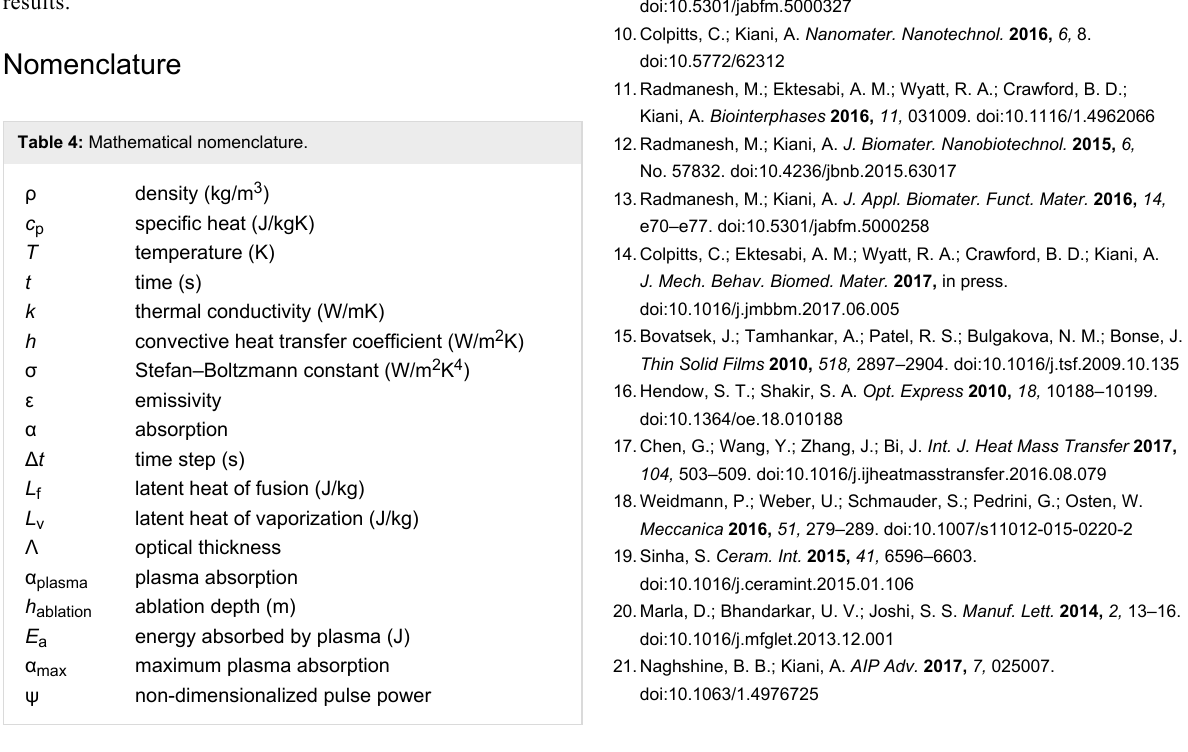
α max is the maximum absorption that corresponds to the highest possible pulse power. ψ is non-dimensionalized pulse power, which is defined as the ratio of the pulse peak power to the highest possible peak power that can be generated by the laser beam. α max and c are calculated from the experimental results.